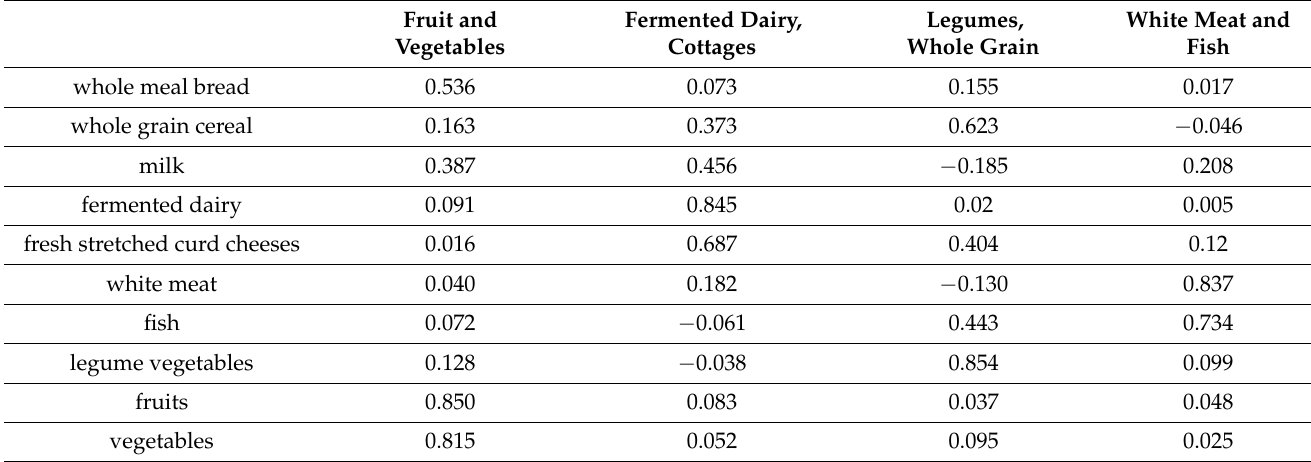
Table 2. Rotated component matrix of pro-healthy food products. Fruit and Vegetables